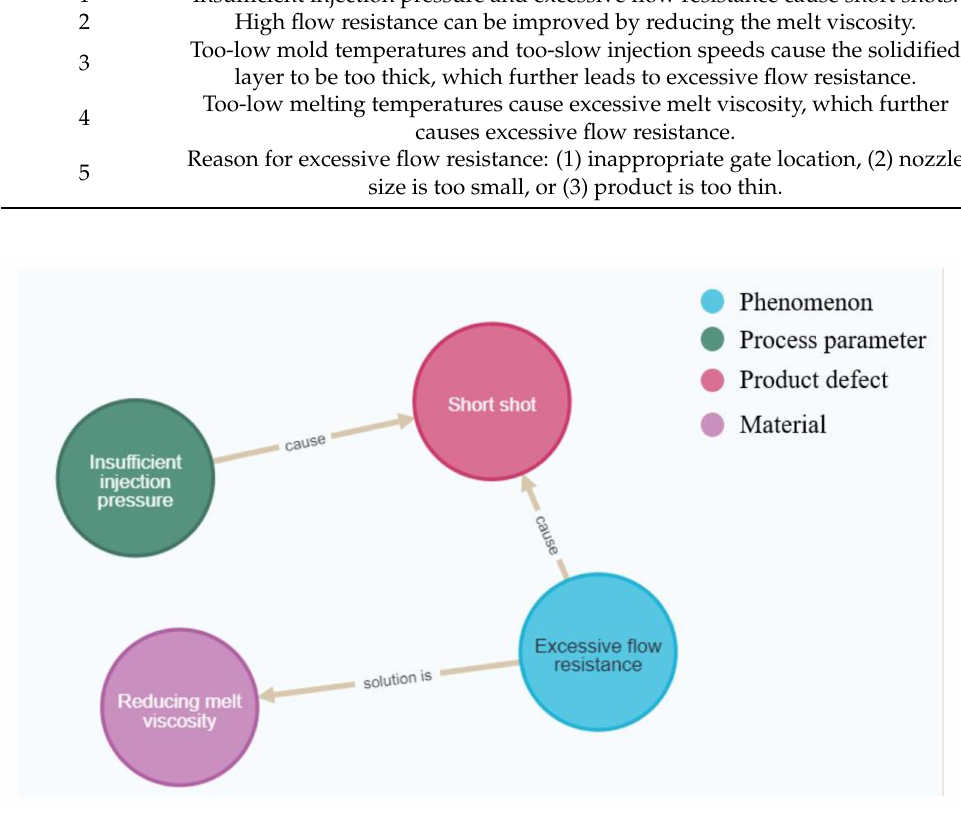
Figure 10. Results of importing the first two data